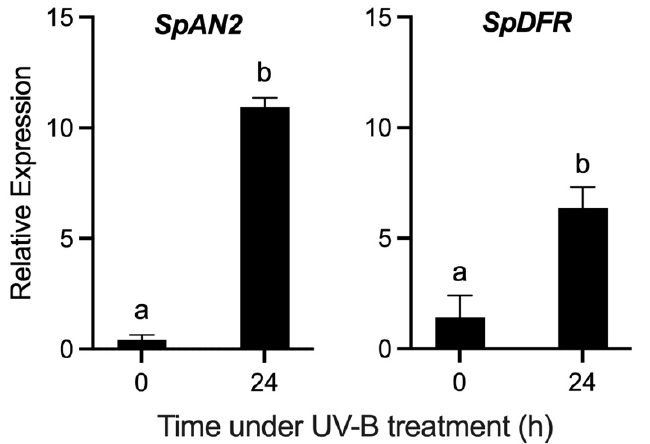
Figure 6. Relative expression levels of SpAN2 and SpDFR genes in the fruit peel of Solanum peruvianum accession QUI958 under UV-B radiation treatment. The expression of each gene was measured at 0 and 24 h of UV-B radiation treatment. Error bars in each column represent the standard deviation of three replicates. The unpaired Student’s t -test was used to compare the means. Different letters indicate significant differences between means. For details see the Section 2.